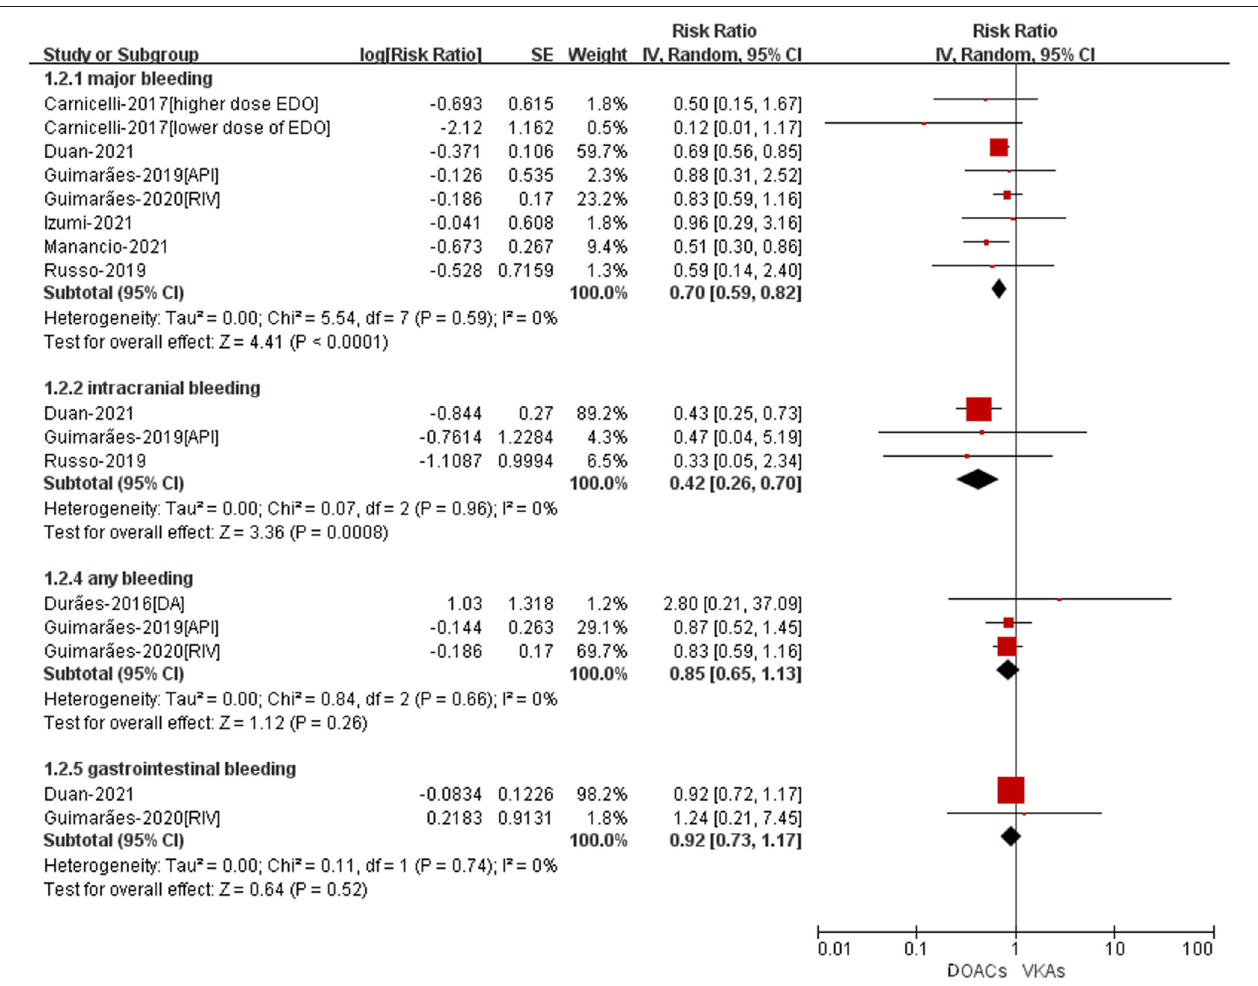
FIGURE 3 | Adjusted safety data of DOACs compared with VKAs among AF patients with BPHV. RCTs, randomized controlled trials; DOACs, direct-acting oral anticoagulants; CI, confidence interval; VKAs, vitamin K